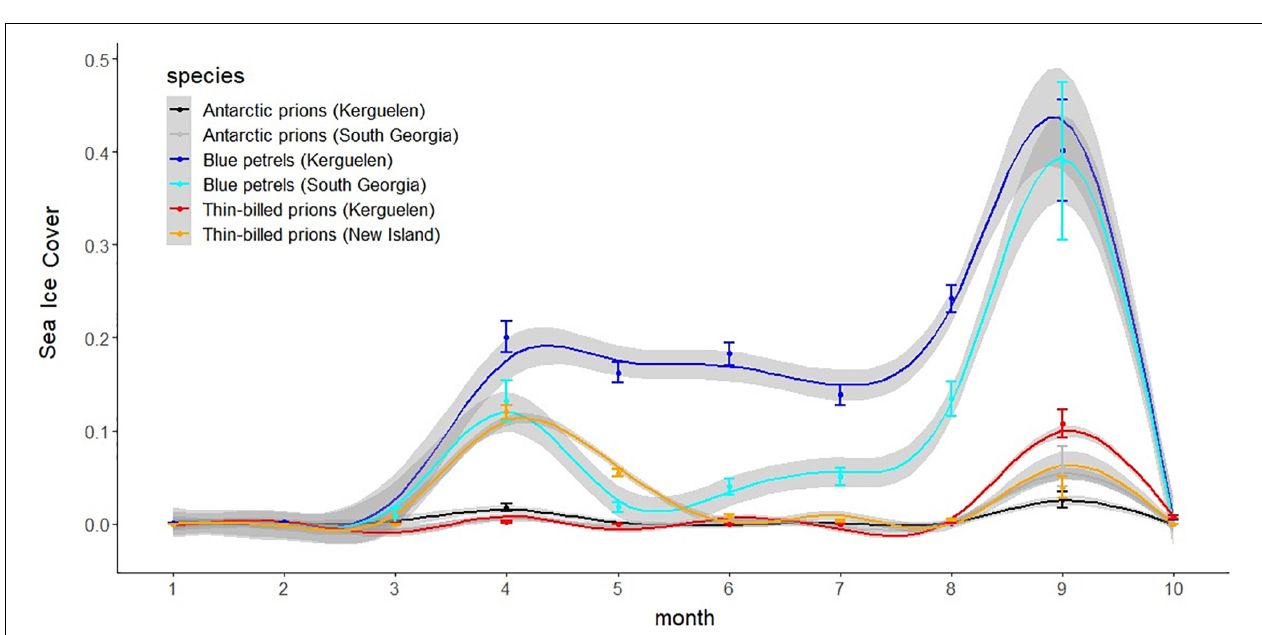
concentrations in feathers (2.41 ± 0.83 µ g/g dw) and blood cells (1.38 ± 0.43 µ g/g dw; Carravieri et al., 2021). Similarly, Adélie Penguins and Emperor Penguins from the Ross Sea had low feather Hg concentrations (0.592 ± 0.015 µ g/g and 1.351 ± 0.058 µ g/g, respectively; Pilcher et al., 2020).